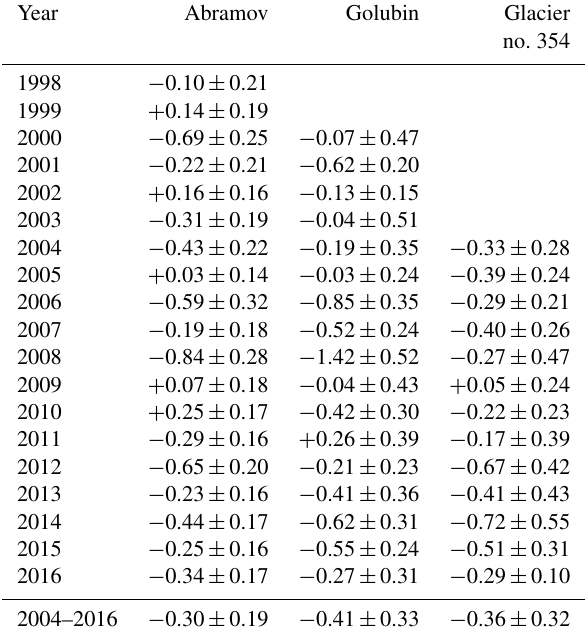
Table 6. Annual, glacier-wide SMB for the three glaciers for the hydrological year B sfc ( fix ) in mw.e.yr − 1 inferred from the mass balance model constrained by TSL